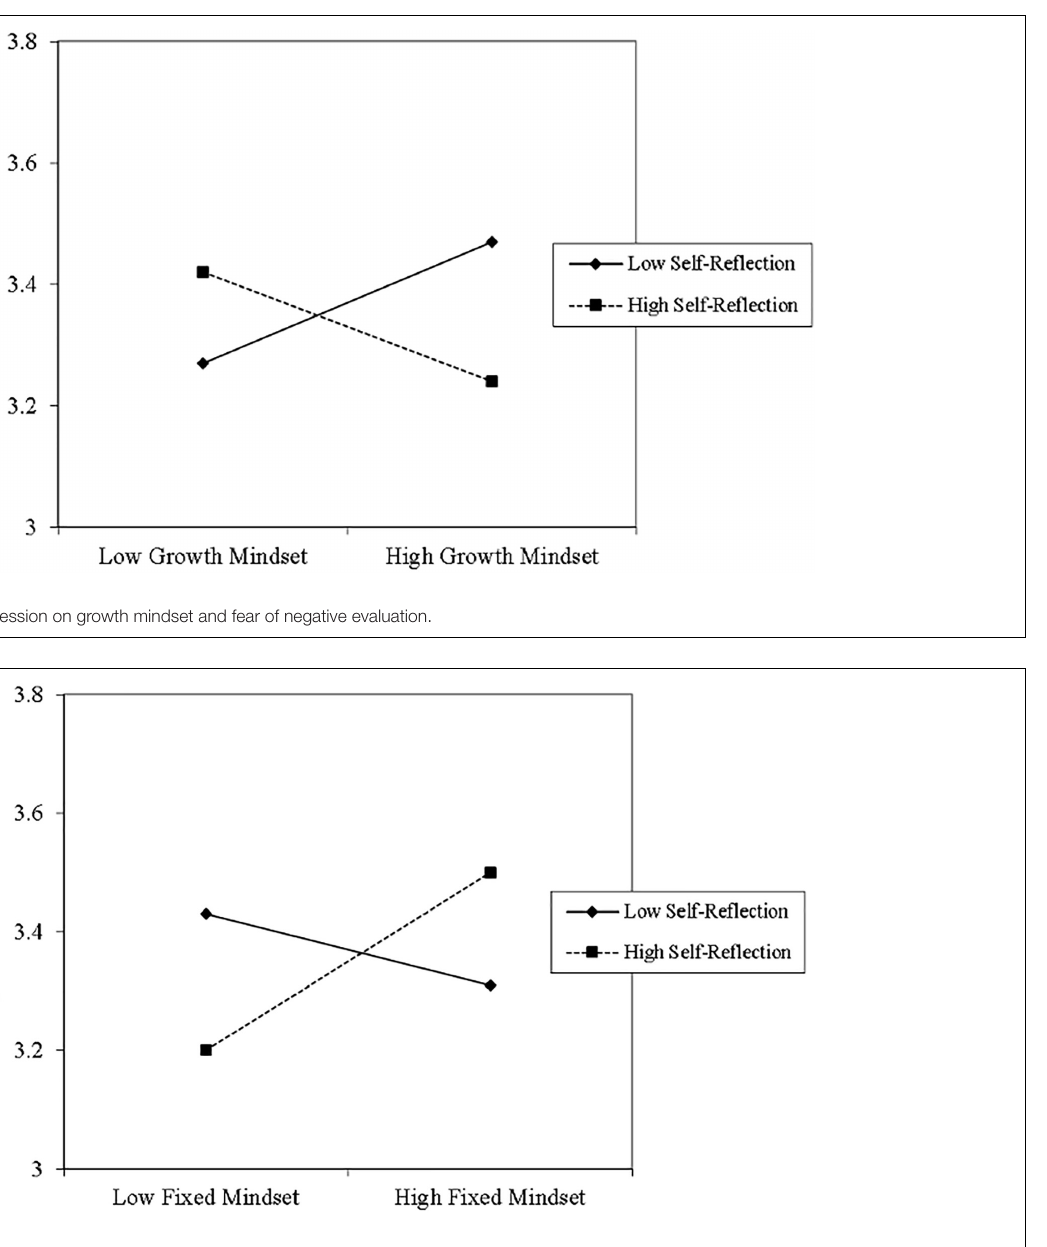
FIGURE 2 | Effect of self-regression on fixed mindset and fear of negative